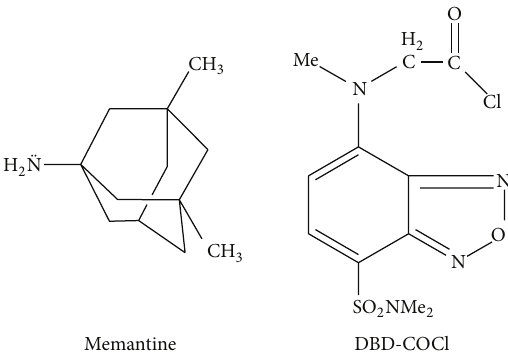
Figure 1: Structures of memantine and